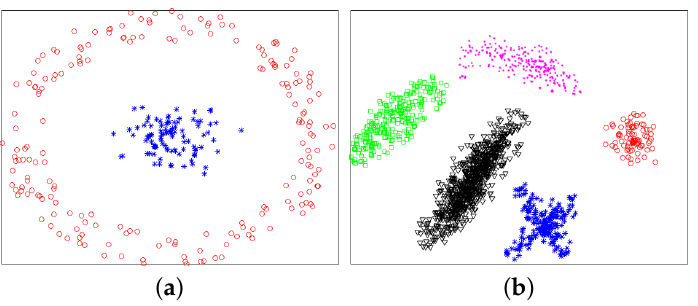
Figure 7. Final clustering results of the proposed IMC. ( a ) Dataset 1. ( b ) Dataset 2.